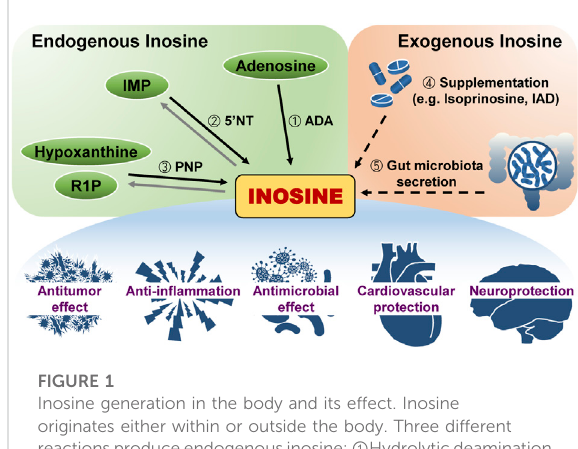
FIGURE 1 Inosine generation in the body and its effect. Inosine originates either within or outside the body. Three different reactionsproduceendogenousinosine: ① Hydrolytic deamination of adenosine by adenosine deaminase (ADA), ② dephosphorylation of inosine monophosphate (IMP) by 5 ′ - nucleotidase (5 ′ NT), and ③ reaction of hypoxanthine and